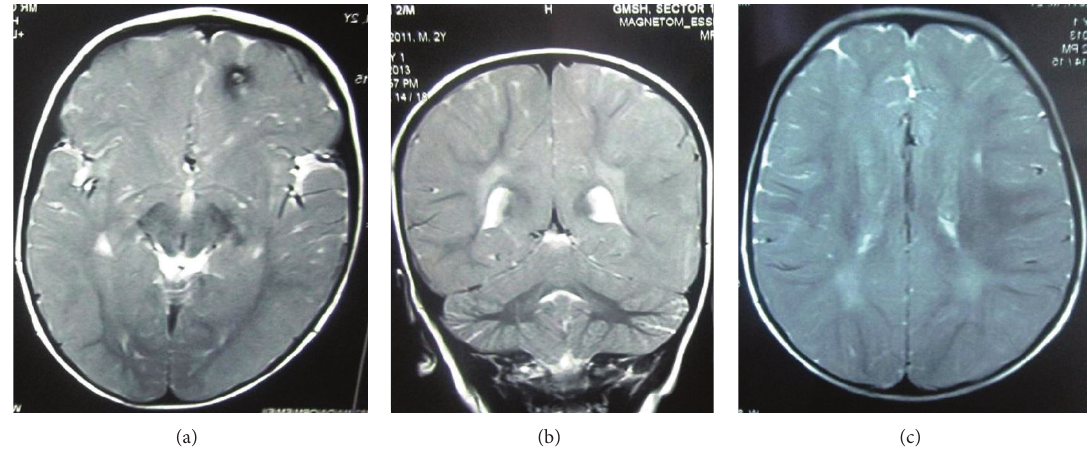
Figure 2: Magnetic resonance imaging of the brain. (a) T2 weighted axial section showing small hypointense focal lesion in left frontal lobe suggestive of cerebral contusion. (b) T2 weighted coronal section and (c) T2 weighted axial section showing ill-defined patchy areas of hyper- intense signal in bilateral peritrigonal and paraventricular parietal white